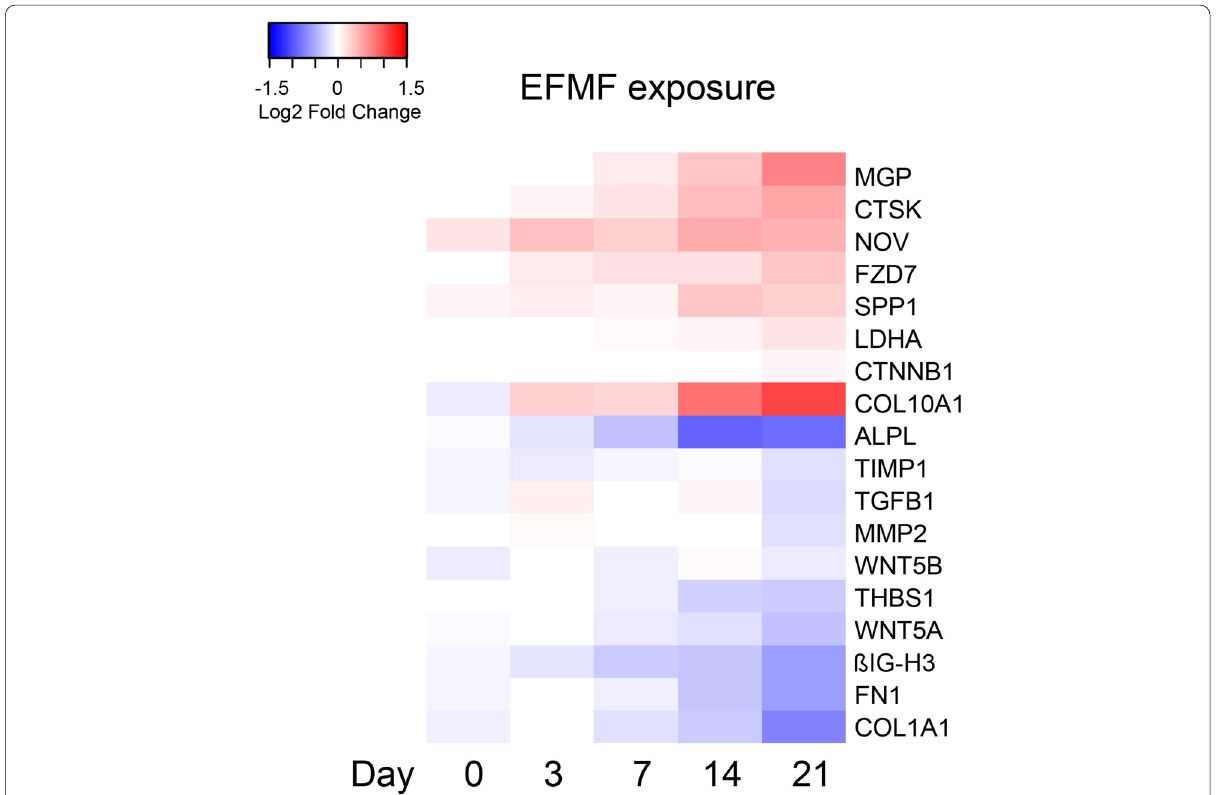
Fig. 3 Differential expressed genes of human primary osteoblasts treated with EFMF vs. control. The heat map shows the mean log2-fold changes in expression of genes important for osteoblast differentiation from 3 independent experiments at time points 0, 3, 7, 14, and 21 days. (see also Fig.